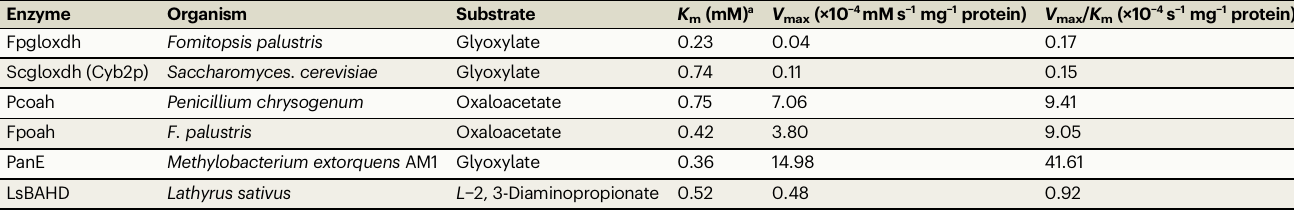
Table 1 | Kinetic parameters of exogenous enzymes in β -ODAP pathway Enzyme Organism